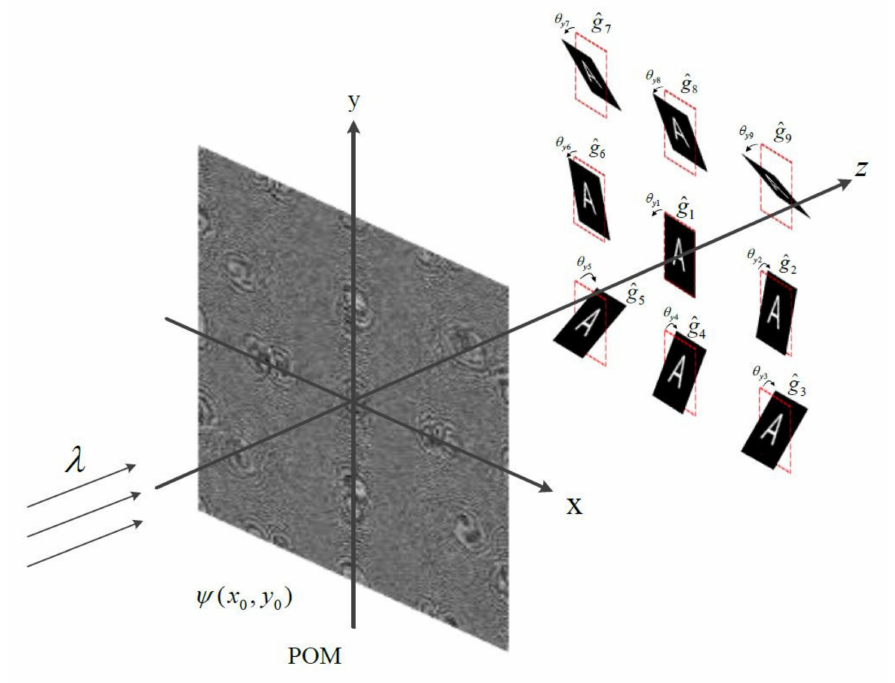
Figure 2. Multi-channel image optical architecture diagram of the single phase revolving the x